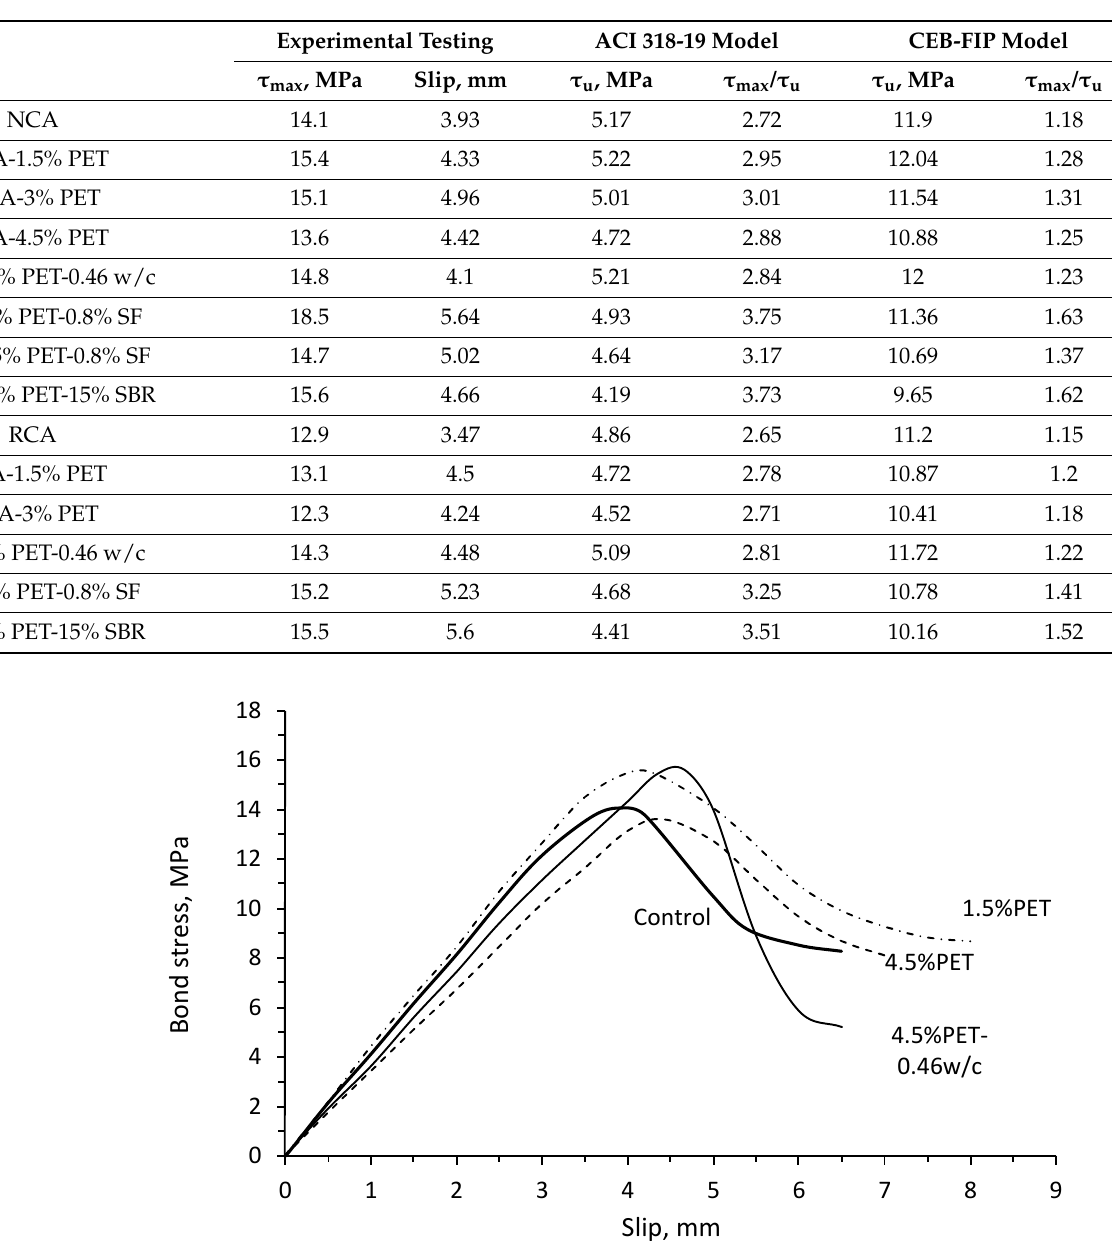
Figure 7. Typical bond vs. slip curves for the control and PET-modified concrete. Regardless of the aggregate type (NCA or RCA), the slip at failure increased with PET additions. For example, this varied from 3.93 mm for the control NCA concrete to 4.96 and 4.24 mm for the NCA-3% PET and RCA-3% PET mixtures, respectively. Similar results are reported by other researchers when testing the bond properties of concrete mixtures containing plastic wastes [27–29]. This was associated with the reduced modulus of elasticity that promotes strain softening, which may be relevant in certain conditions to attenuate the brittle failure of structural members subjected to reversed cyclic loading [50]. A moderate relationship with R 2 of 0.52 exists between τ max and slip at failure (Figure 8); hence, mixtures possessing higher bond strengths exhibited higher slips at